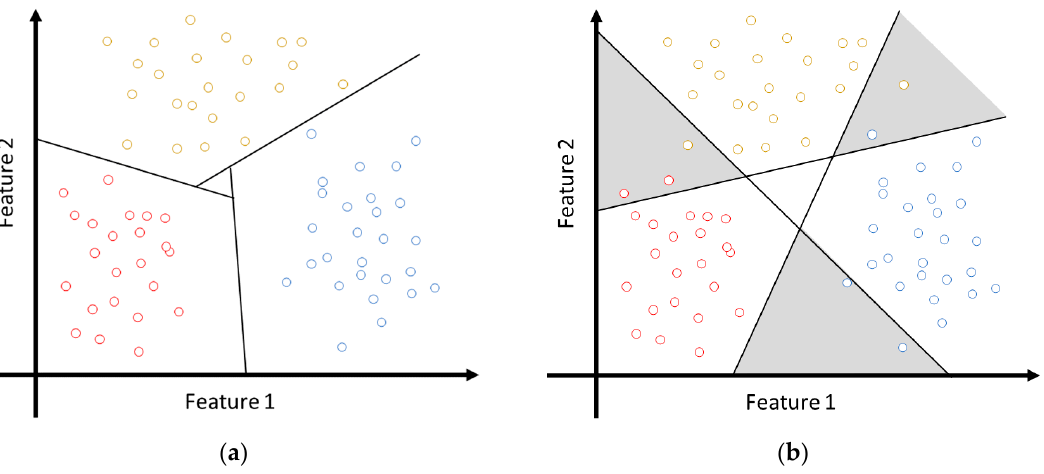
Figure 3. ( a ) One-vs-one method of classifying hyperplanes; ( b ) one-vs-all method of classifying hyperplanes.